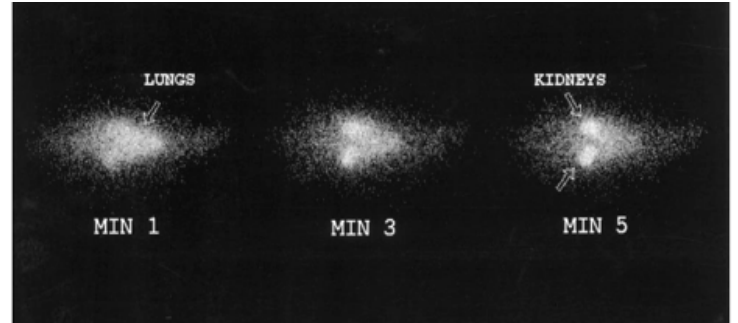
Figure 5. In vivo distribution of 131 I-GLP-1 in a rat shortly after intravenous administration. Re- printed with permission from Hassan et al. (1999) [41]. Reprinted with permission from Hassan et al. (1999)